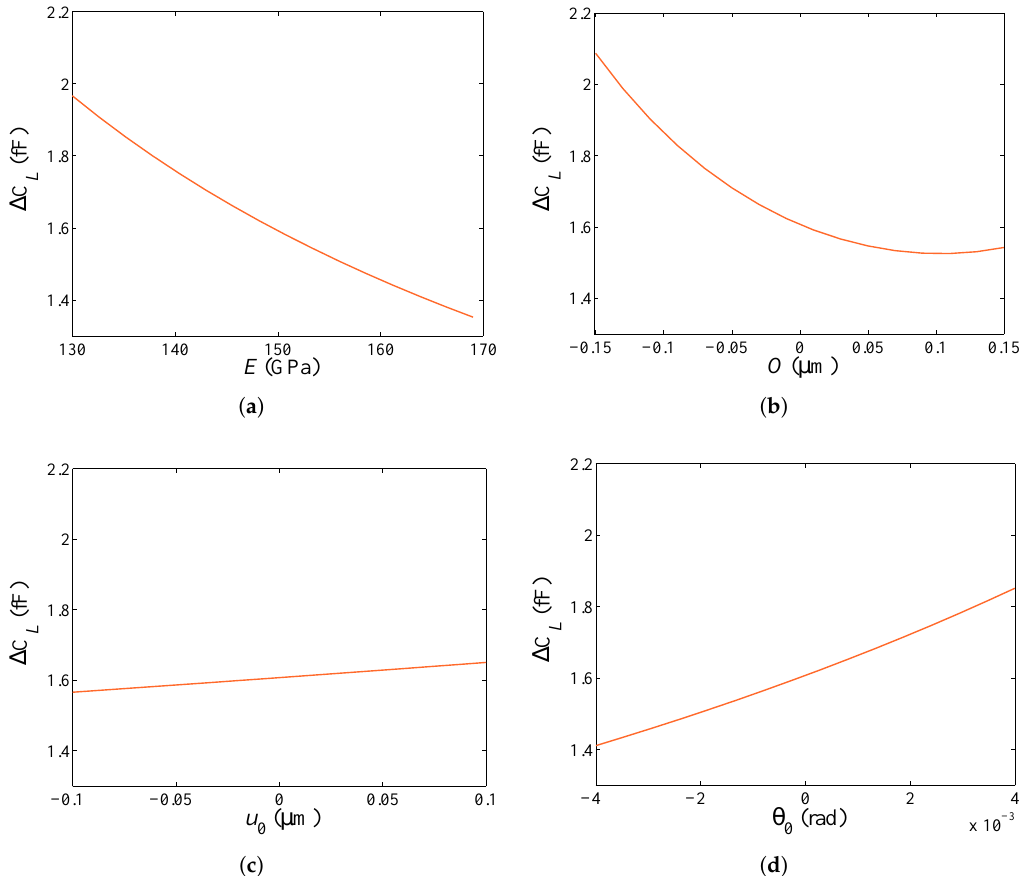
Figure 4. Lateral actuation through V L = 15 V, sensitivity of the capacitance change ∆ C L to: ( a ) E ; ( b ) O ; ( c ) u 0 ; ( d ) θ 0